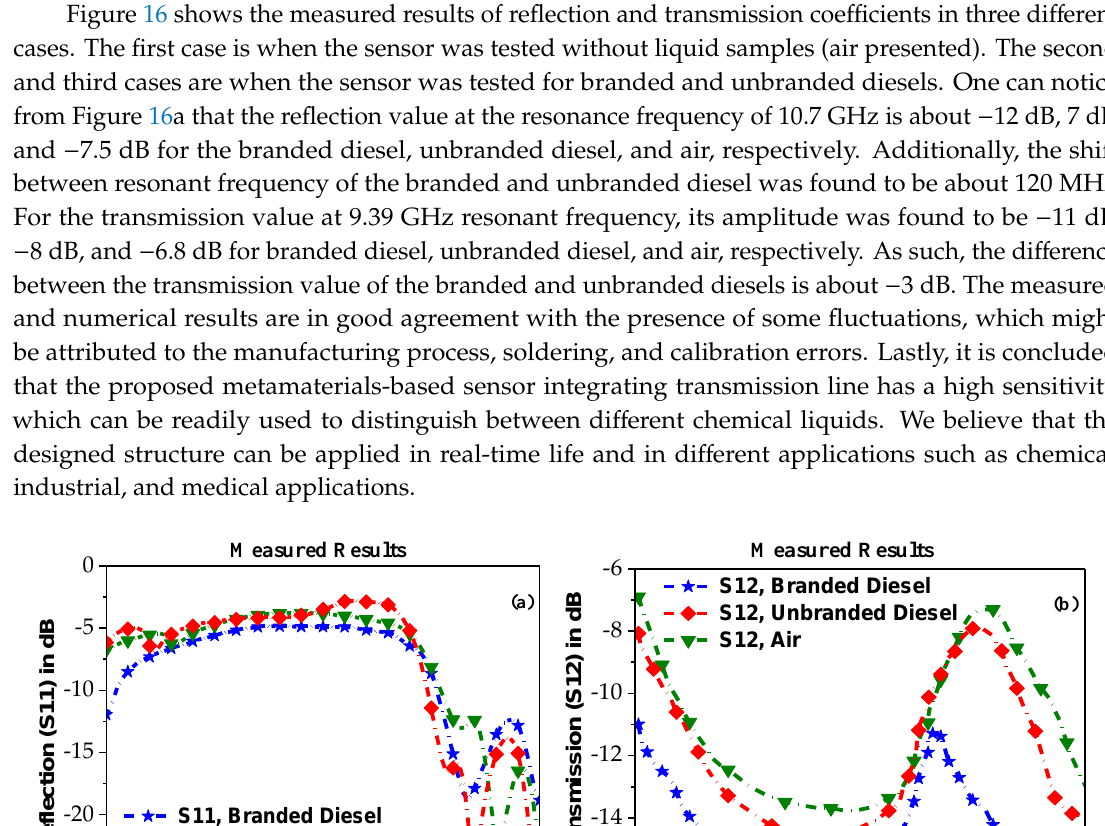
Figure 15. ( a ) Simulated result for air, branded diesel, and unbranded diesel samples: reflection coefficient and ( b ) transmission coefficient.